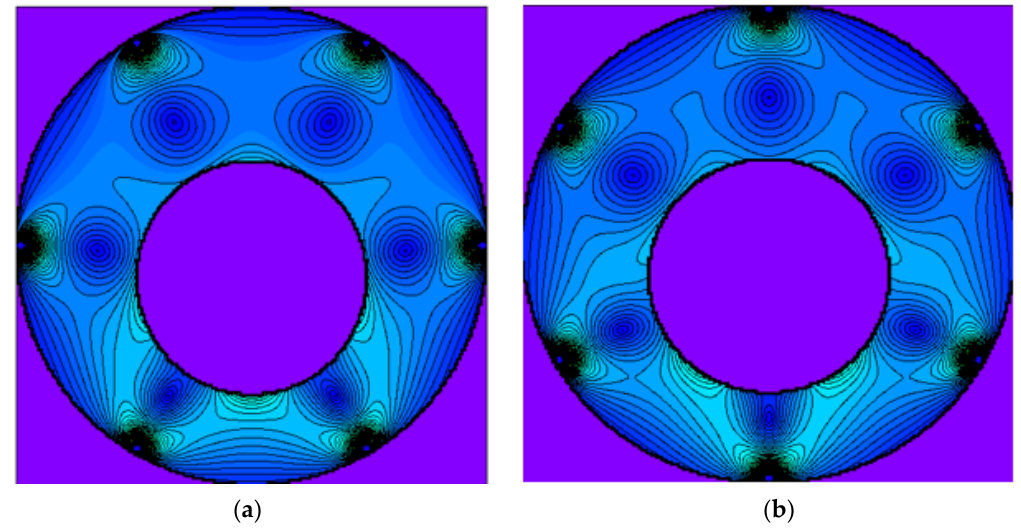
Figure 22. Isochromatic fields for the eccentric ring symmetrically loaded by six concentrated equidistant forces: ( a ) λ (cid:107) = 0; λ ⊥ = 1; λ = 1; θ 1 = π /3; θ 2 = − π /3; ( b ) λ (cid:107) = 1; λ ⊥ = 0; λ = 1; θ 1 = π /6; θ 2 = − π /6.